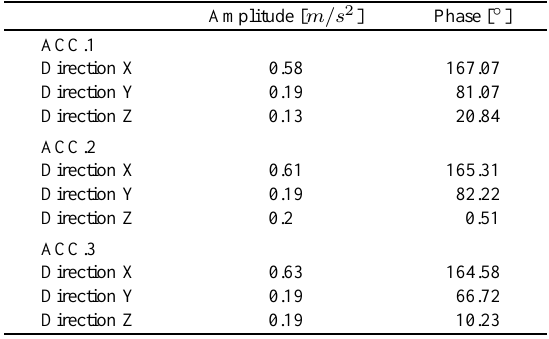
Table 2 Calculated and experimental values of amplitude (in m/s 2 ) and